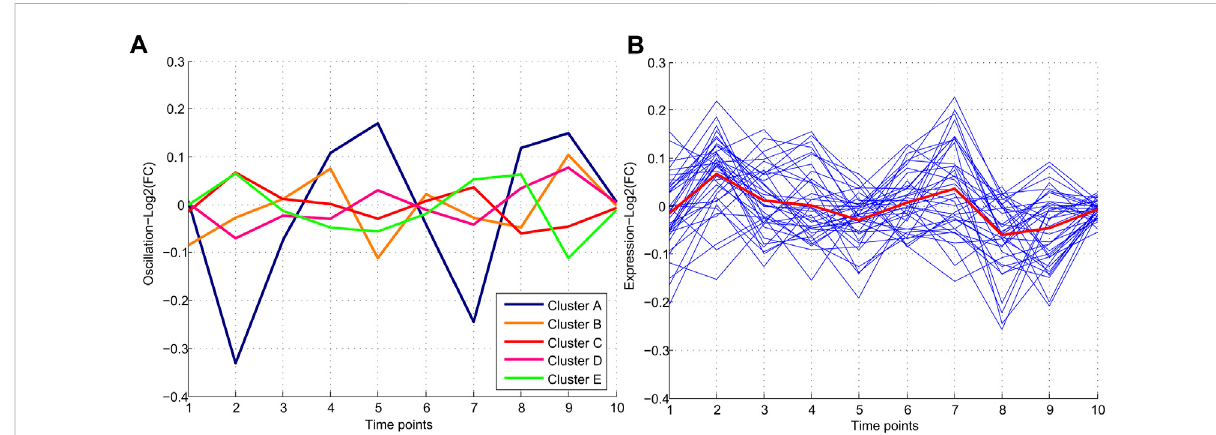
FIGURE 2 Patterns of miRNA expression during nine different time points. (A) Five clusters were detected in clustering analysis. Pattern C which includes 37 miRNAs, demonstrates the minimum and Pattern A demonstrated the maximum oscillation among the other patterns. (B) Pattern C consisting of 37 miRNAs with a similar oscillation pattern which demonstrated the lowest